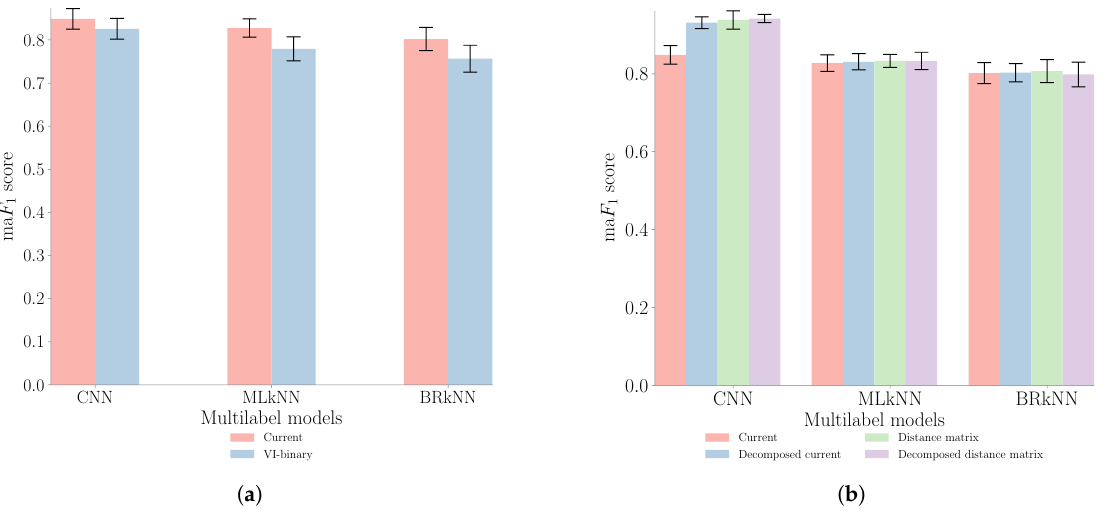
Figure 8. ma F 1 score performance comparison between the proposed CNN model and the two baselines for different inputs features: ( a ) Comparison between voltage-current (V-I) binary image and current activation features; ( b ) Comparison between the activation current based